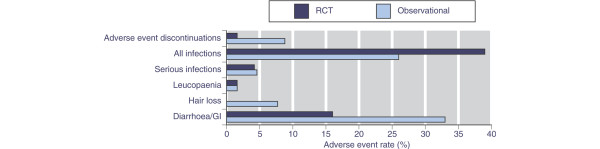
Comparison of adverse event rates with mycophenolate mofetil in systemic lupus erythematosus in a pooled analysis of randomised controlled trials (RCT) and observational studies reporting on patients with lupus nephritis. GI, gastrointestinal adverse events.